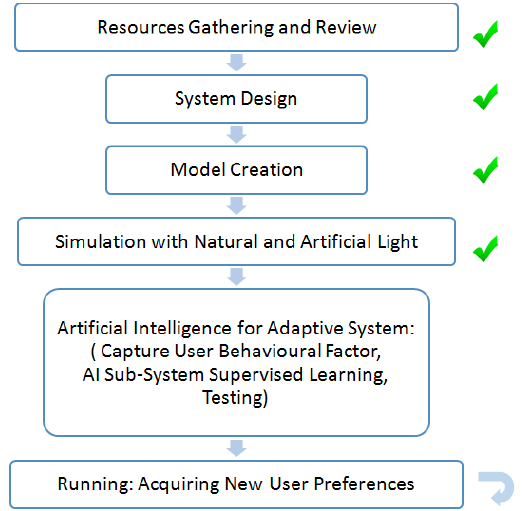
Figure 5. Research steps for the adaptive lighting system.